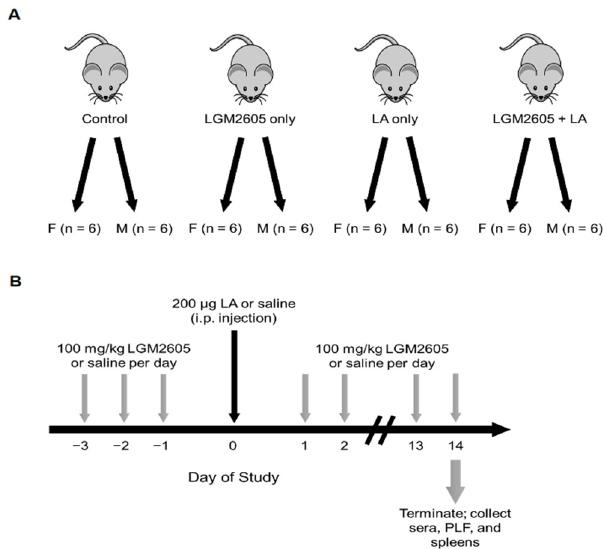
Figure 1. Assignment of treatment groups and schedule of treatment. ( A ) Mice were randomly divided into one of 4 treatment groups, with 6 males and 6 females per group. Each treatment is designated by diet/i.p. injection: control (saline/saline), LGM2605 only (LGM2605/saline), LA only (saline/LA), and LGM2605 + LA (LGM2605/LA). ( B ) For 3 days prior to i.p. injection, mice received daily treatment of LGM2605 or saline control via Medigel cups. LA fibers or saline control were then delivered by i.p. injection. Mice received daily treatment of LGM2605 or saline control for an additional 14 days following LA exposure. On day 14, mice were euthanized, and tissues were collected for subsequent analysis.